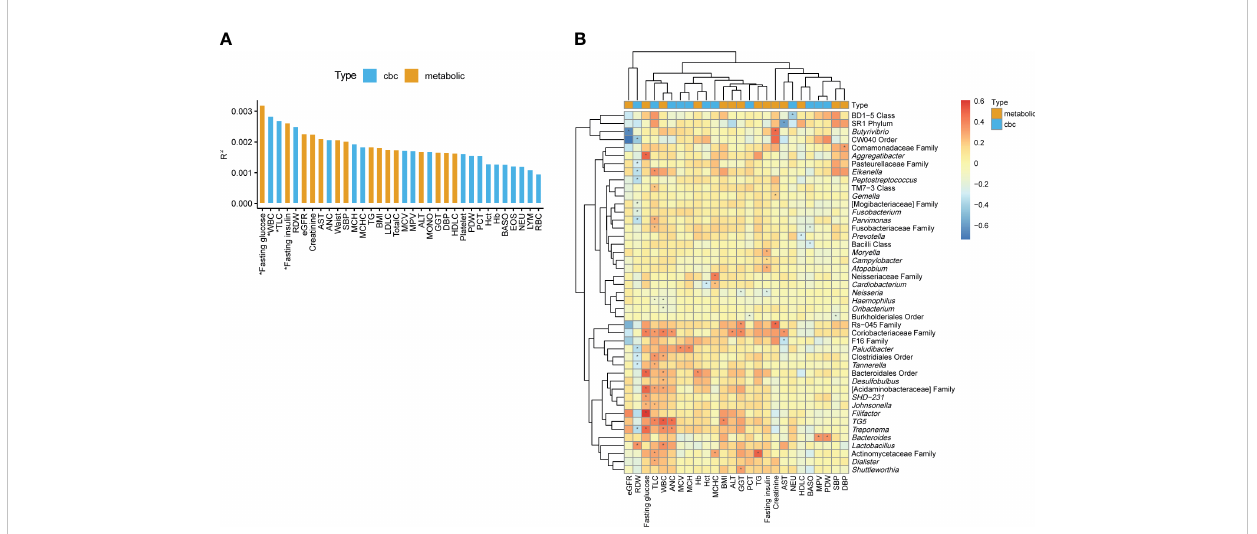
FIGURE 2 Associations of the oral microbiome with different biomarkers. (A) Effect size of biomarkers on the oral microbiome composition based on Aitchison distance after adjusting for age and sex. Bars are colored by the type of biomarkers. *, false discovery rate (FDR)<0.1. (B) Heatmap of the association between the biomarkers and the relative abundances of genera. The color of the heatmap shows the regression coef fi cient estimates adjusted for age and sex. *,